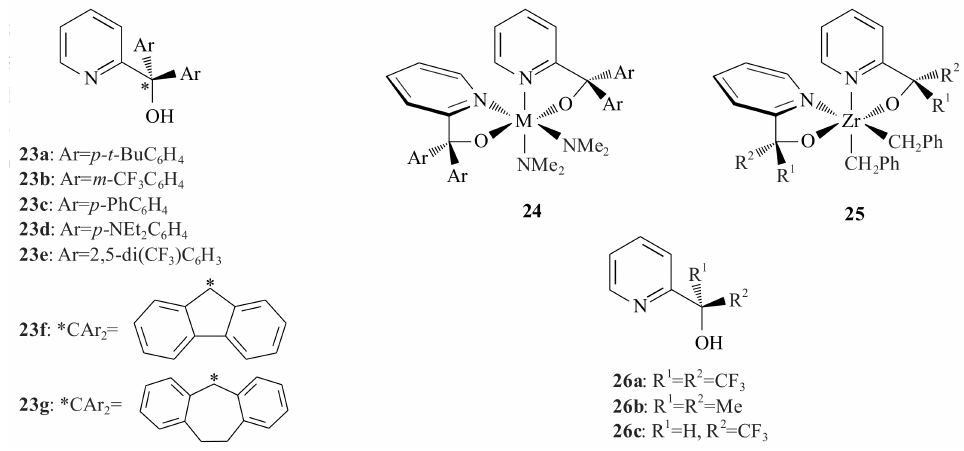
Figure 6. Ligands and complexes used in polymerization